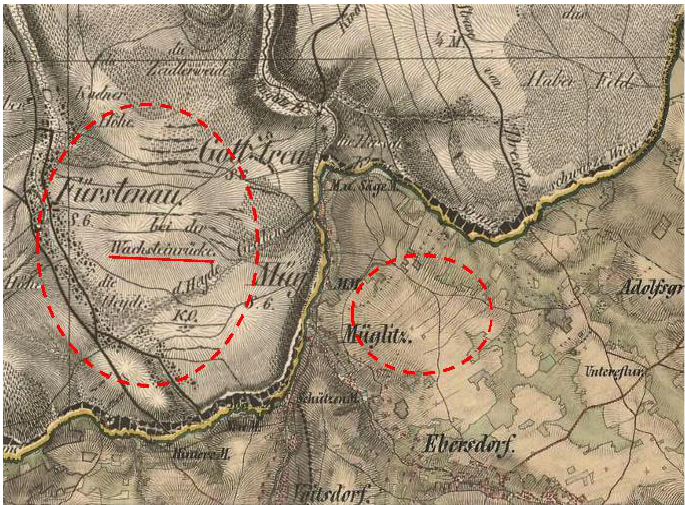
Figure 6. Cross-border site of the former villages of Mohelnice (Czechia, Germany) and Fürstenau (Germany) in the Krušné Hory Mts on a map of the Second Military Survey: red circles indicate location of HALs map signs. [data sources: Arcanum Maps — Europe in the XIX. century: Adapted with permission from Refs. [72,73]].